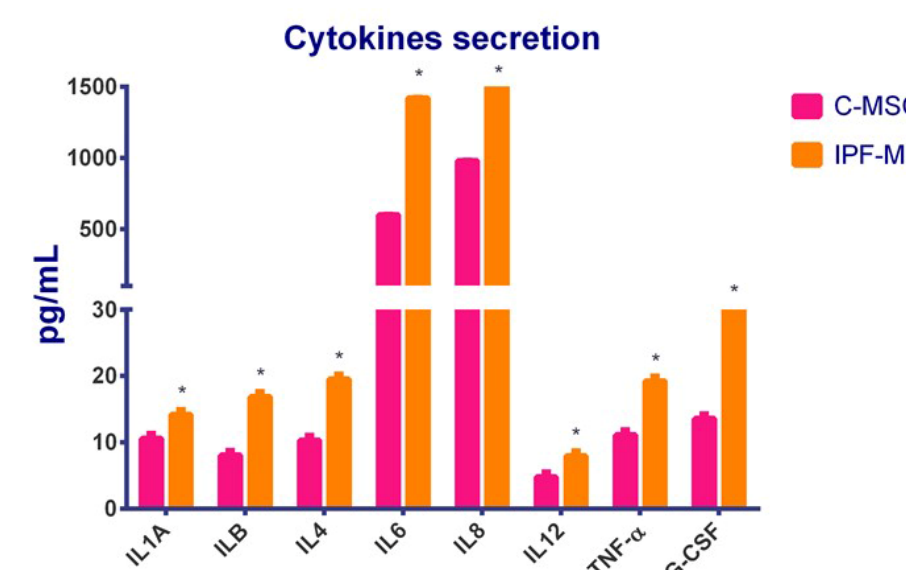
Figure 7. C-MSCs vs. IPF-MSCs: cytokines secretion. The secretion of IL1A, IL1B, IL4, IL6, IL8, IL12, TNF- α , and G-CSF was evaluated by ELISA. Levels of secretion were measured on collected medium after 72 h of culture and are referred to as pg / mL. Data are means ± SD from analyses performed on three separate experiments in triplicates. The * indicate significative di ff erences between C-MSCs and IPF-MSC; (one-way ANOVA; p < 0.05). C-MSCs: mesenchymal stem cells (MSCs) from controls; IPF-MSCs: MSCs from patients with IPF (idiopathic pulmonary fibrosis)